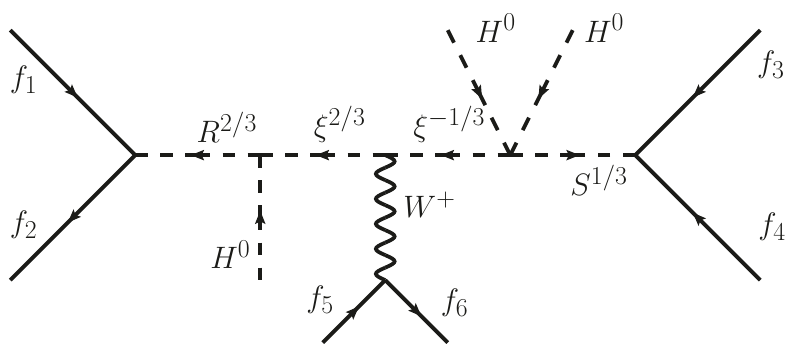
Figure 1 . New physics operator leading to non-zero neutrino masses in our proposed model. Here f i represents SM fermions. From the left-most (right-most) vertex, it is clear that R 2 ( S 1 ) carries F = 0 ( F = − 2 ), where F = 3 B + L is known as the fermion